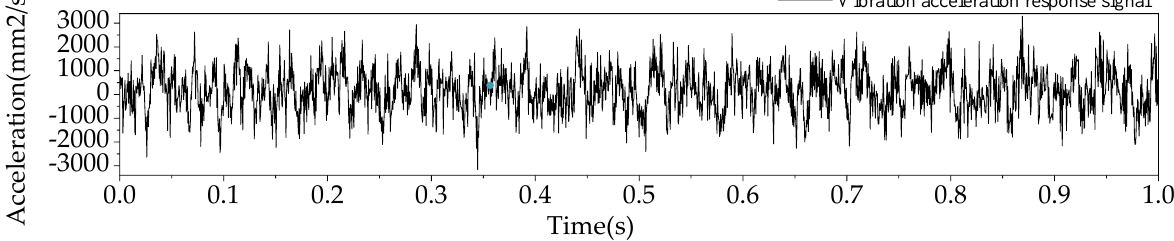
Figure 4. Vibration signal after superimposing random noise in normal condition.